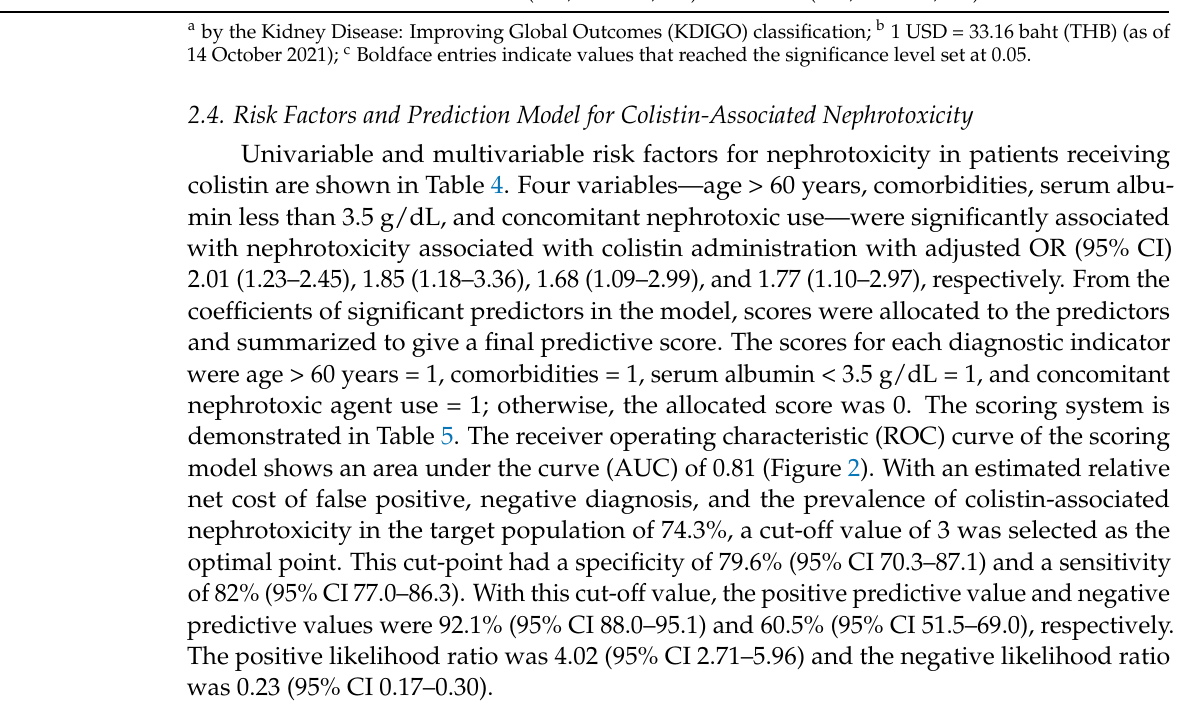
Values for the Patients Values for the Patients p Value without Nephrotoxicity with Nephrotoxicity (N = 99) (N = 282)